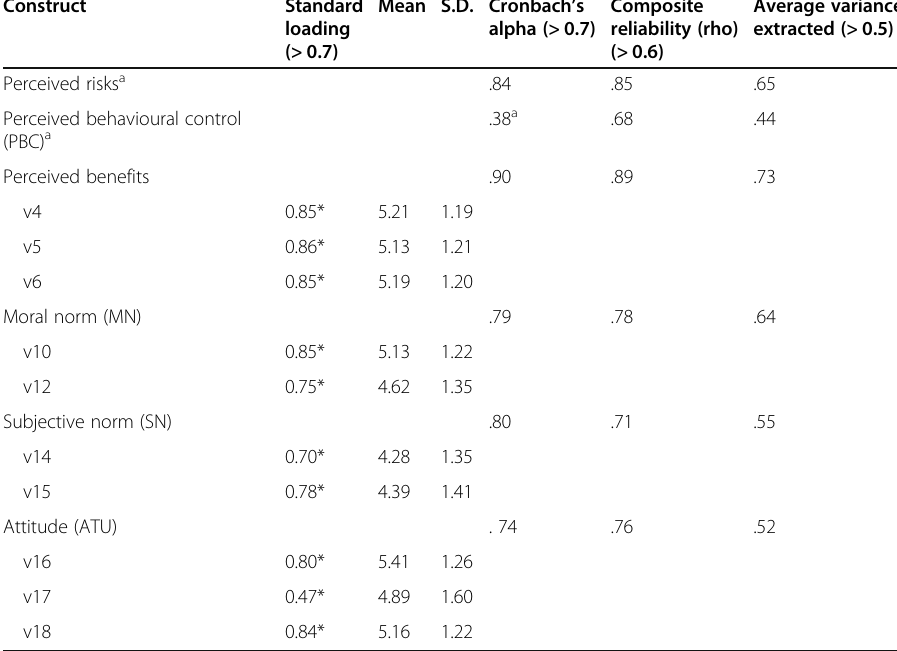
Table 3 Agroforestry: measurement properties of the multi-item constructs ( N = 1829) Construct Standard